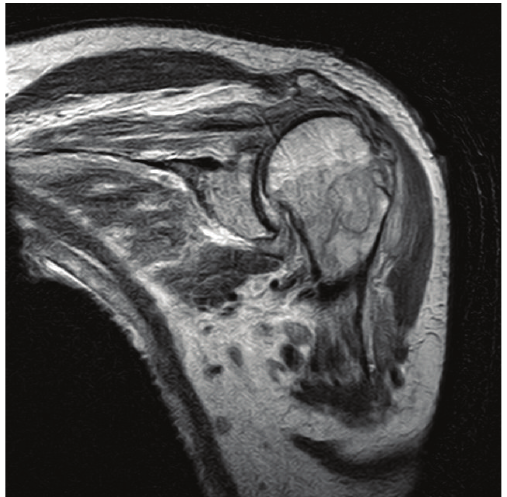
Figure 2: MRI left shoulder.